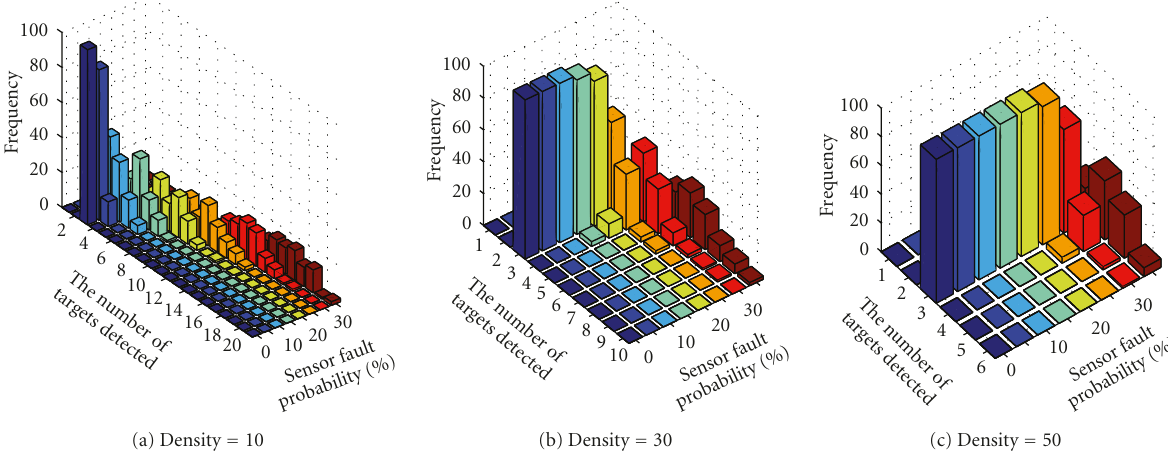
Figure 2: The number of targets detected when three targets are deployed. Here, T = 9 and density = 10,30,50,